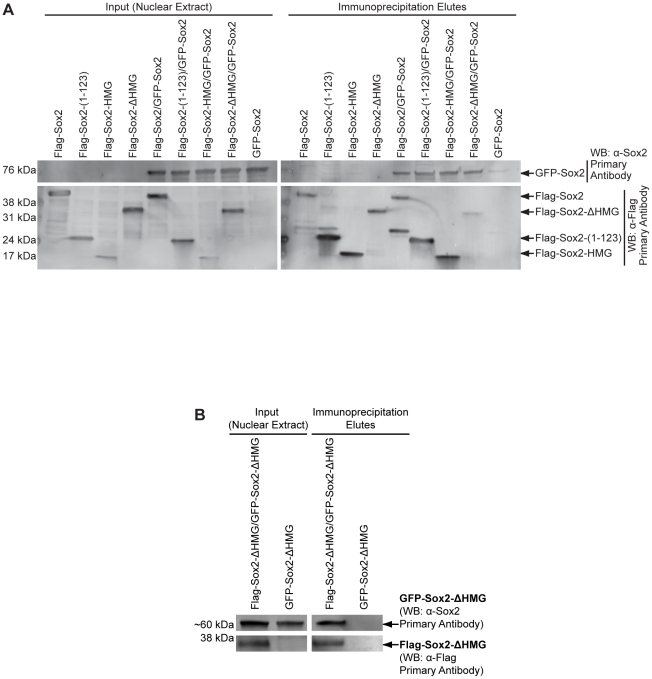
Mapping domains necessary for Sox2 to mediate its self-association.(A) 293T cells were transiently transfected with expression constructs for GFP-Sox2 and the Flag-Sox2 constructs indicated. Nuclear extracts (input lanes) used for co-immunoprecipitation of Flag-Sox2 constructs and associated proteins are presented as western blot analyses (left panels). α-Sox2 was used to visualize GFP-Sox2 (top-left), and α-Flag was used to visualize the Flag-Sox2 constructs indicated. M2-beads were used to co-immunoprecipitate Flag-Sox2 constructs and their associated proteins. Immunoprecipitation eluates were used in western blot analyses (right panels), and probed for GFP-Sox2 (α-Sox2, top-right) or the Flag-Sox2 proteins (α-Flag, bottom-right). (B) Co-immunoprecipitation of GFP-Sox2-ΔHMG by Flag-Sox2-ΔHMG. Experimental design was the same as described for Figure 5A. These experiments were repeated multiple times, and similar results were observed.